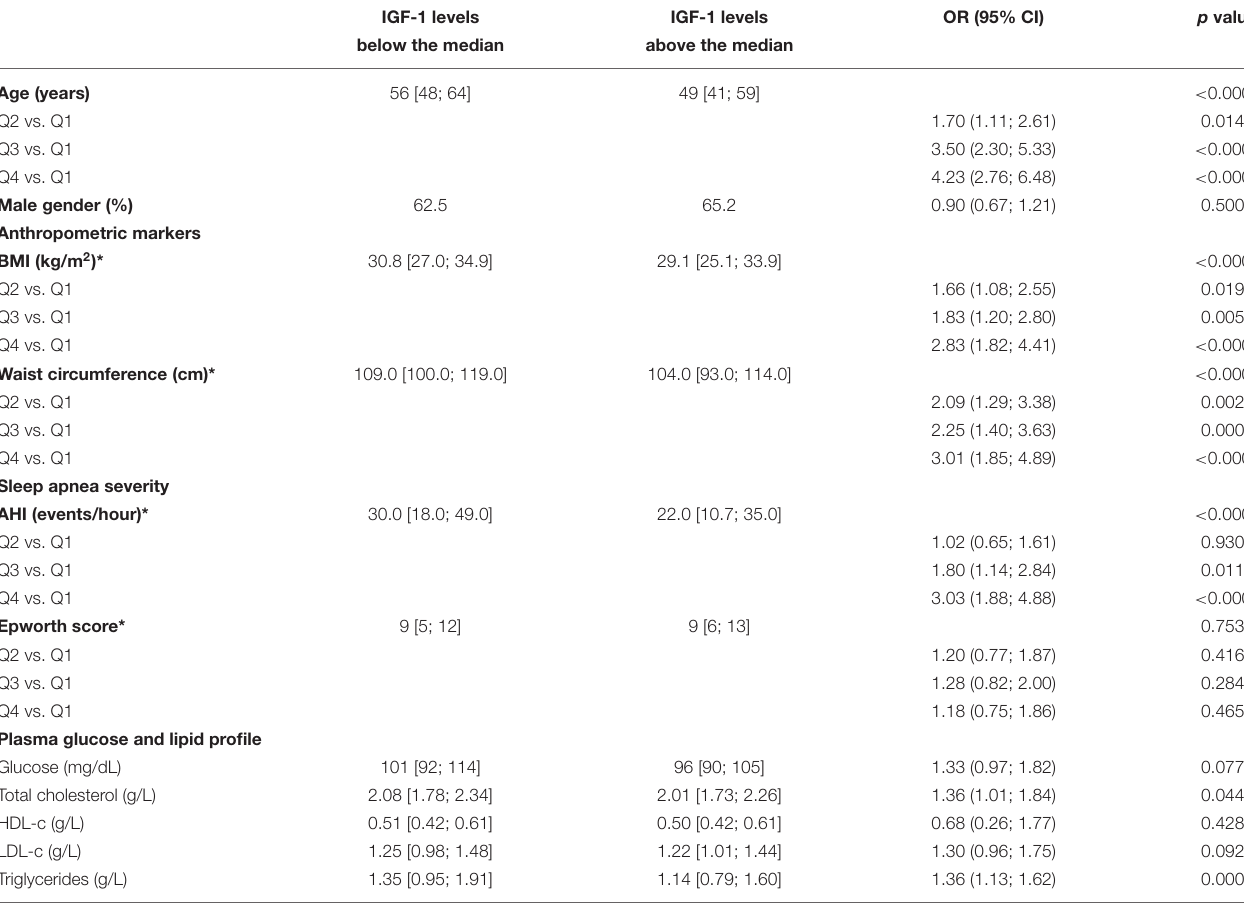
TABLE 2 | Factors associated with low IGF-1 levels (below the median) in univariate logistic regressions. IGF-1